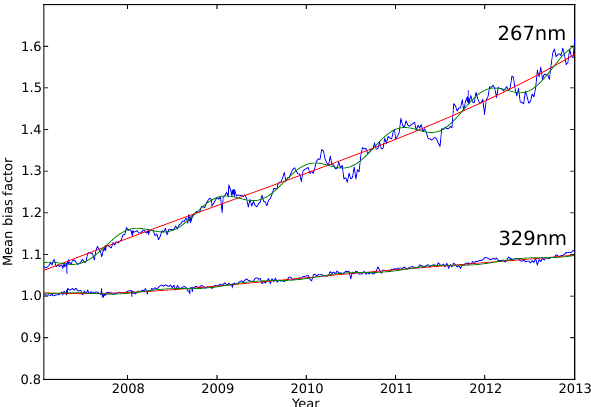
Figure 7. Average tropospheric NO 2 columns over East Asia mea- sured by GOME-2 for 2007–2013 (Logarithmic colour